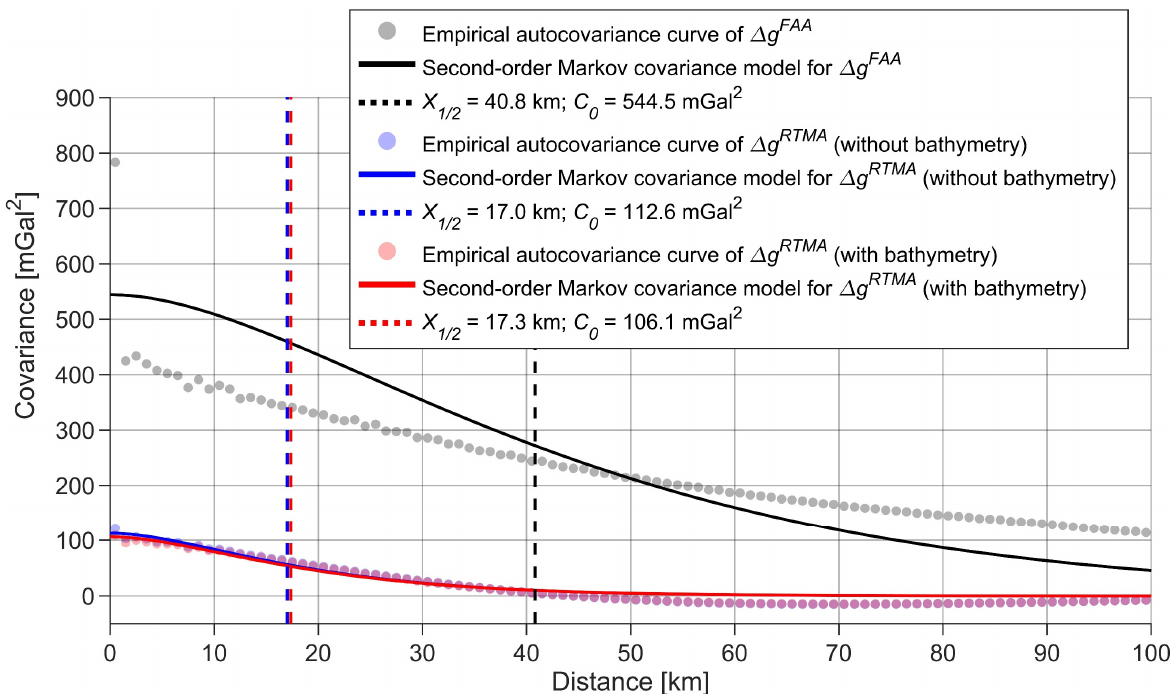
Figure 9. Empirical autocovariance curves and respective least-squares fitted second-order Markov covariance models with the associated correlation lengths X 1/2 (shown with dashed lines) and signal variances C 0 (see the